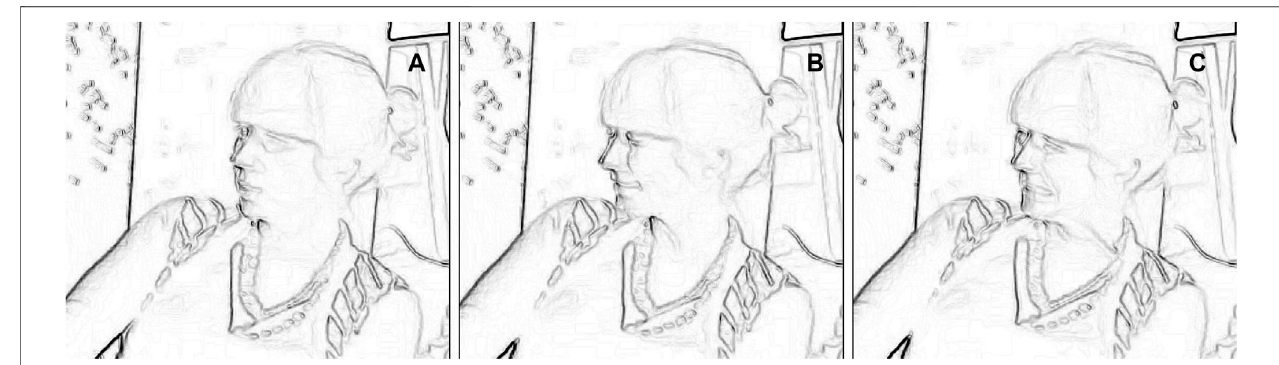
FIGURE 3 | (A) : End of line 3, “ ELR ” . (B) : Swallow at line 4. (C) : Line 6: sides of the mouth turned down, neck tightened, displaying “ trouble ”